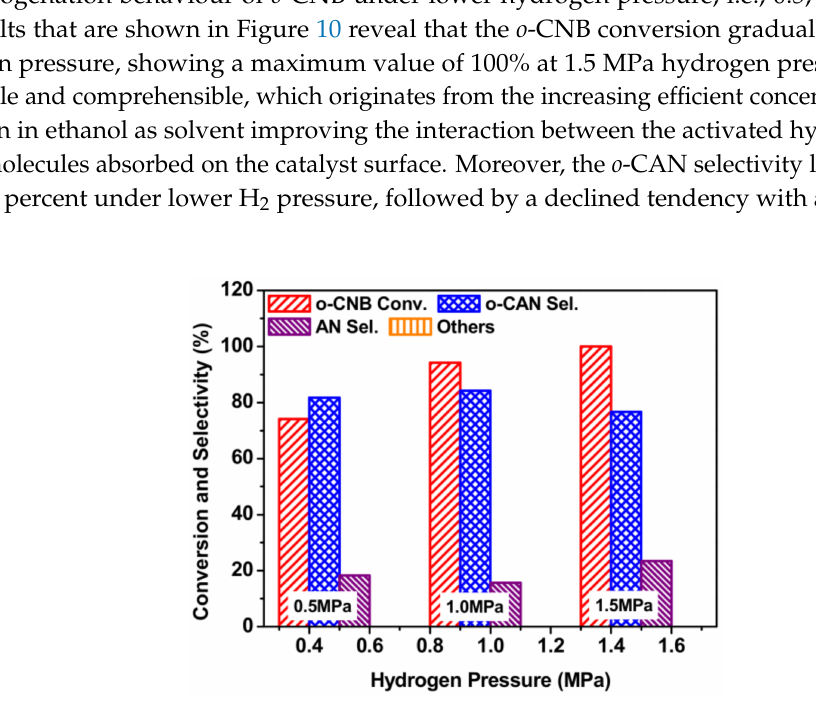
Figure 10. Dependence of the o -CNB hydrogenation upon hydrogen pressure. Conditions: 60 ◦ C, 0.5 h, m cat. = 20 mg, n o -CNB / n Pd = 9000:1, V ethanol = 5